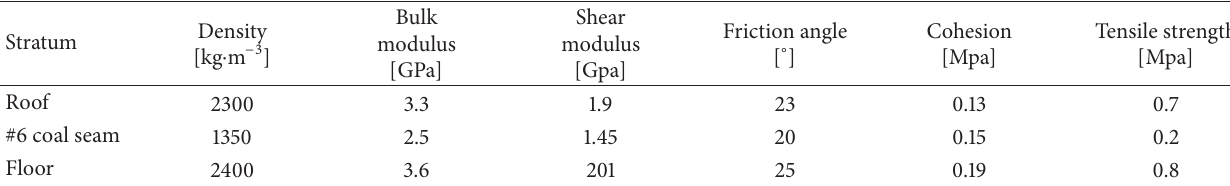
Table 3: Physical and mechanical properties of the